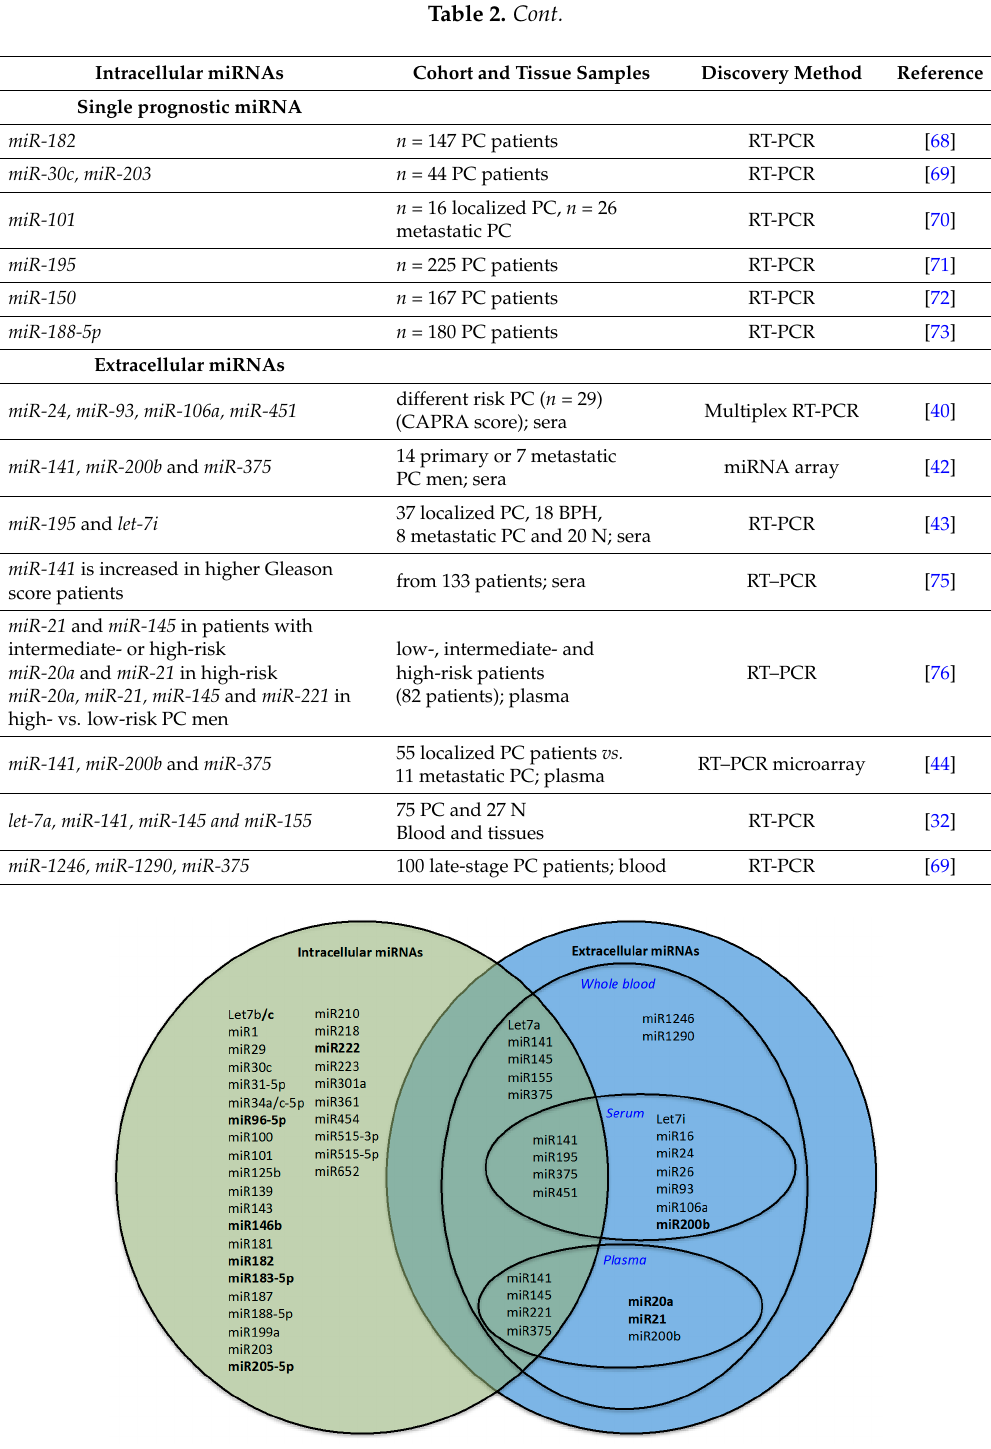
Figure 3. Venn diagram: Extracellular and intracellular prognostic miRNAs. In bold: miRNAs altered in more than one signature. At the intersection of the sets: miRNAs in common among extracellular and intracellular prognostic miRNAs.